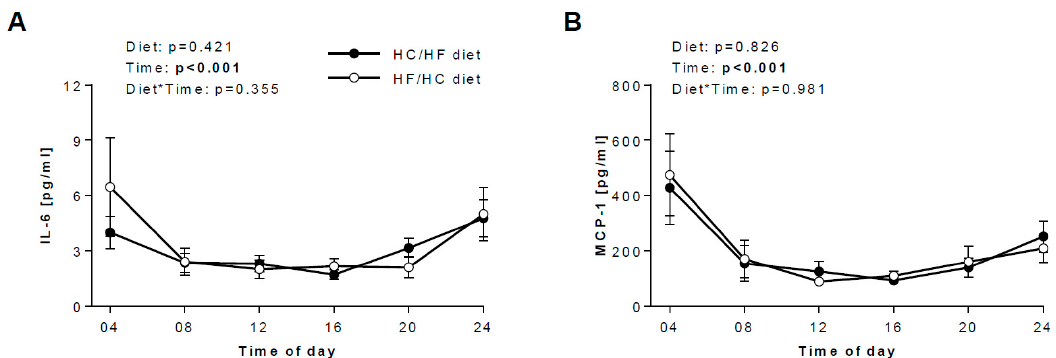
Figure 3. Salivary inflammatory biomarkers in response to the HC/HF and HF/HC diet. Effects of the HC/HF diet (black circles) and the HF/HC diet (open circles) on 24-h concentrations of ( A ) IL-6 ( n = 14) and ( B ) MCP-1 ( n = 22). Repeated measures two-way ANOVA was applied to determine the effect of diet, time and diet*time interaction. Data are means ± SEM. HC/HF diet, isocaloric high-carb meals until 13:30 and isocaloric high-fat meals between 16:30 and 22:00; HF/HC diet, reversed order of meal sequence, IL-6, interleukin 6; MCP-1, monocyte chemoattractant protein-1.